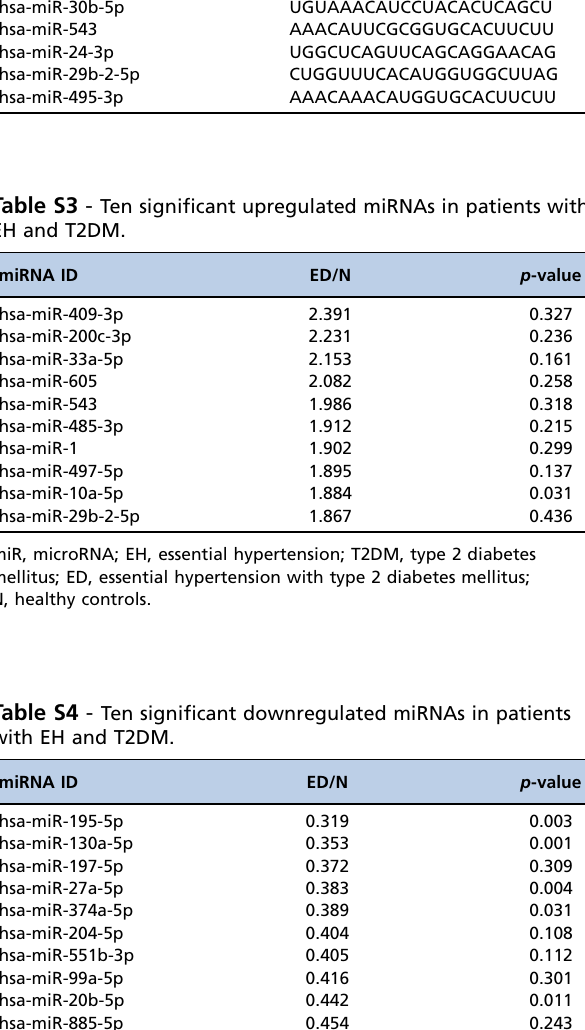
N, healthy controls.